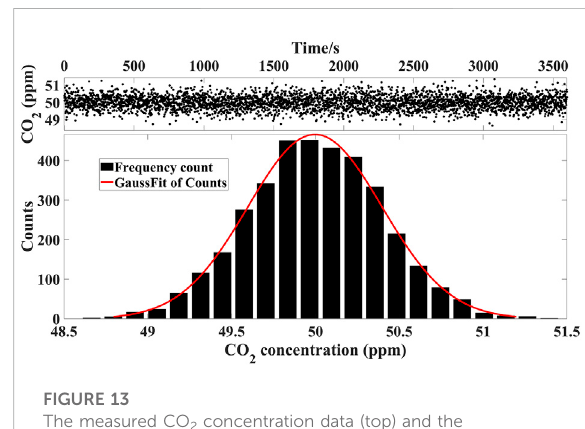
FIGURE 13 The measured CO 2 concentration data (top) and the distribution histograms of deviation (bottom). The red line depicts a Gaussian pro fi